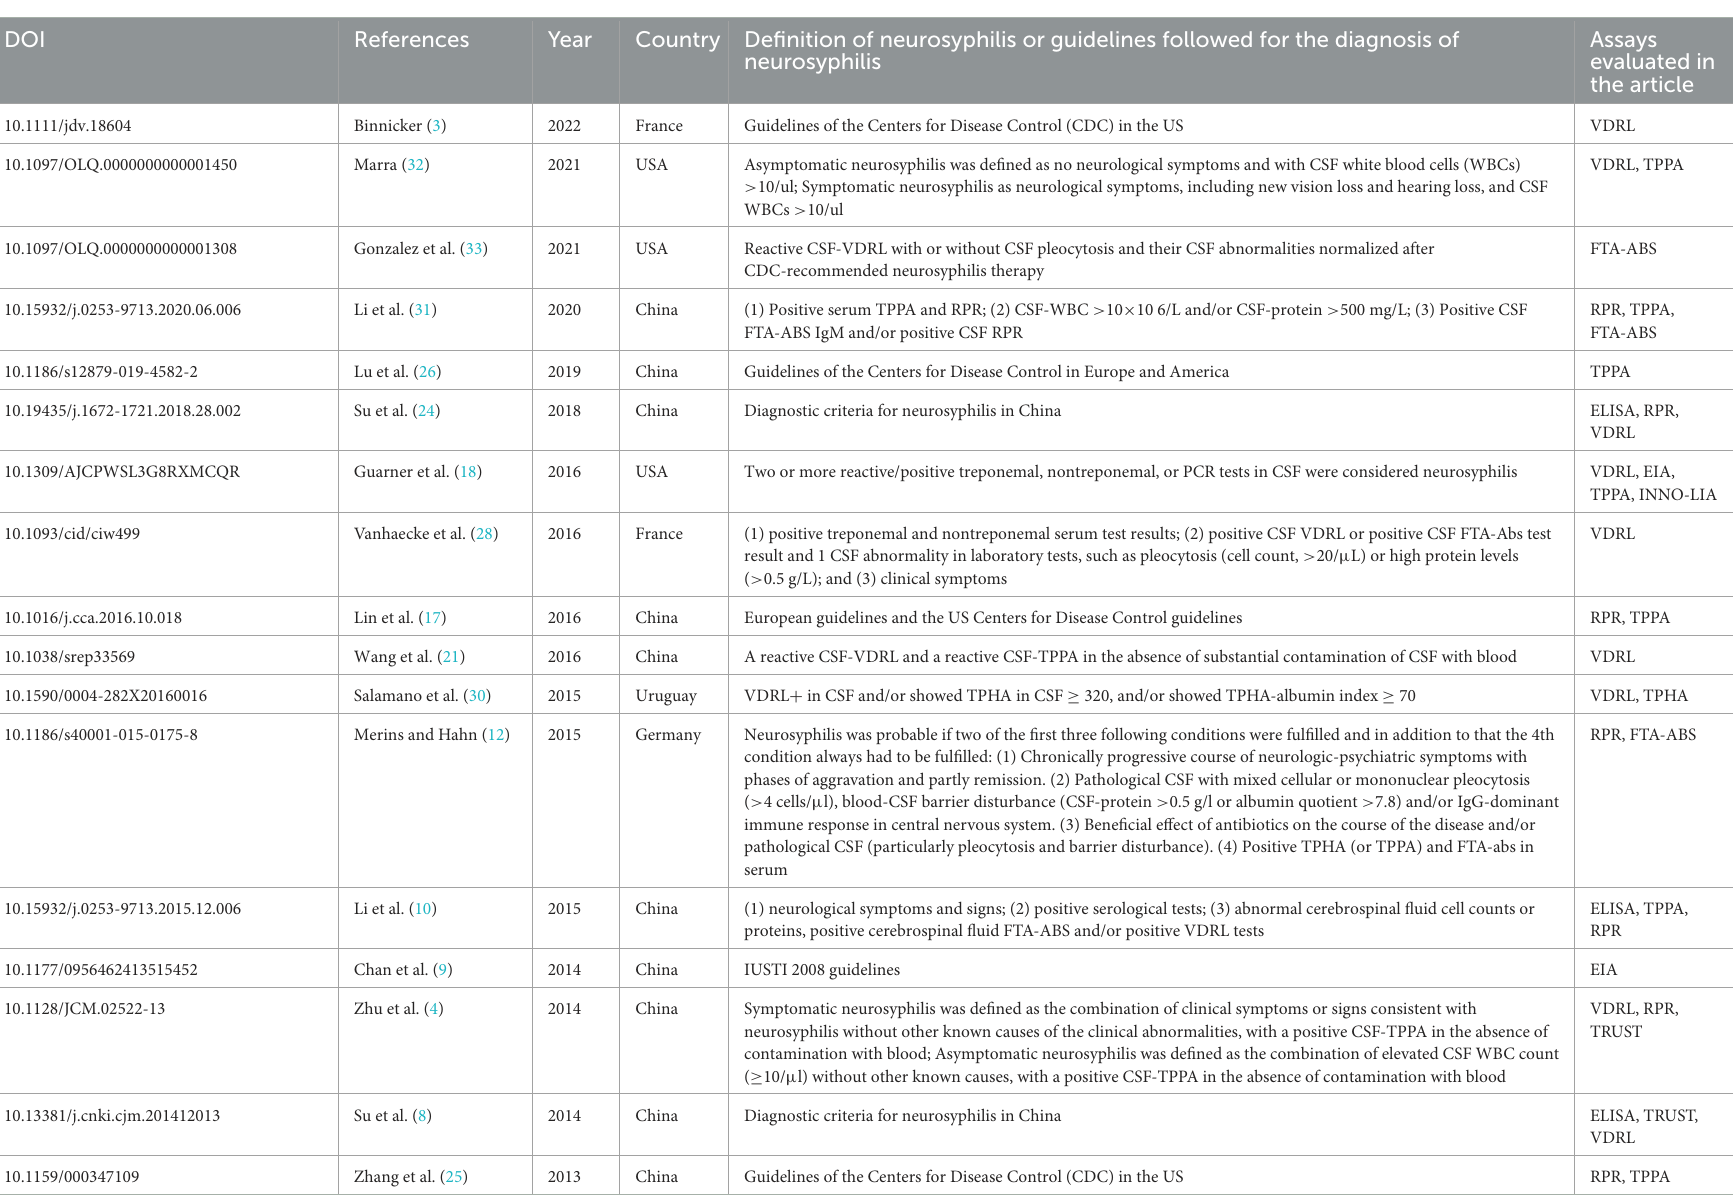
TABLE 1 Characterization of included